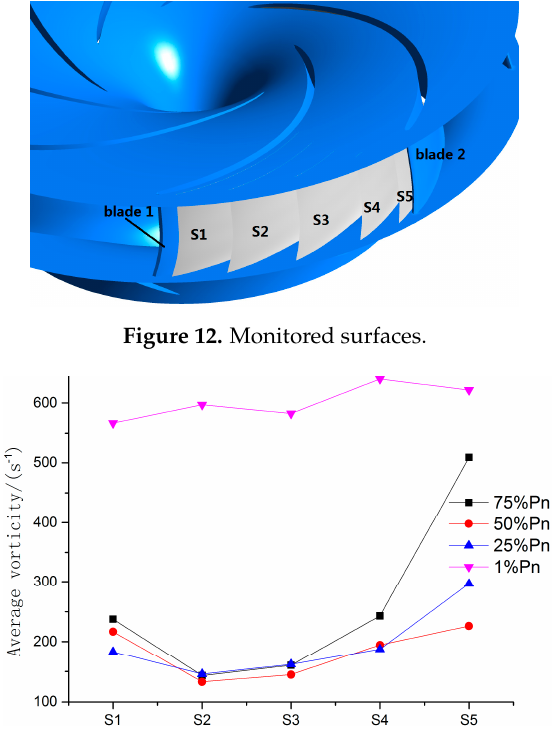
Figure 13. Average vorticity at monitored surfaces in non-full rated operating states.